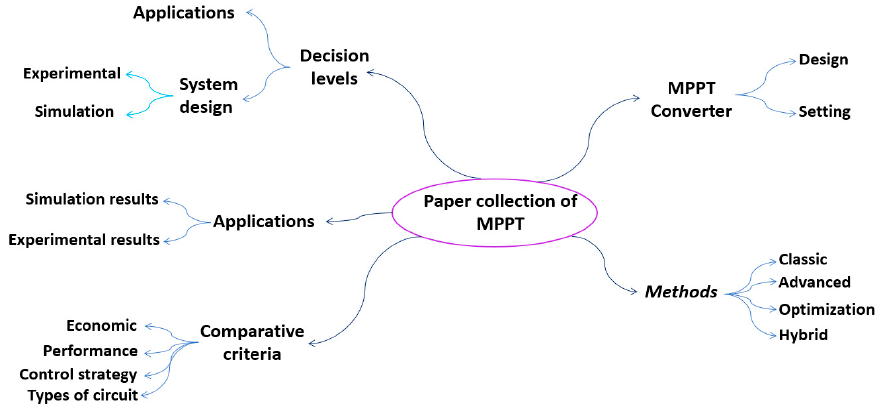
Figure 7. Mind map for category selection.